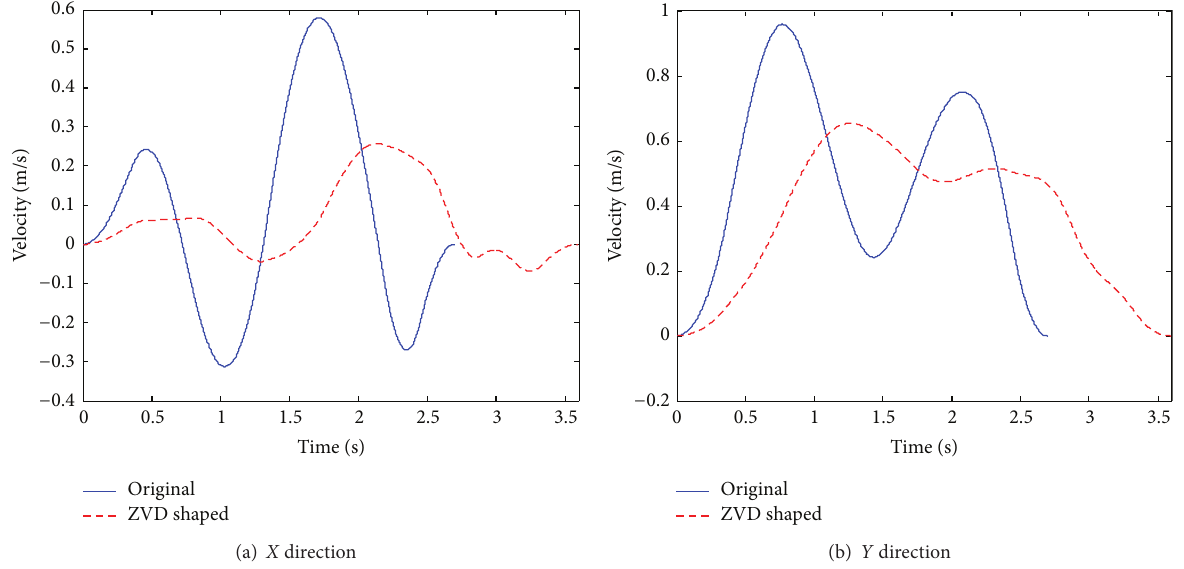
Figure 8: Original and ZVD shaped velocity in task space: (a) X direction (b) Y direction.